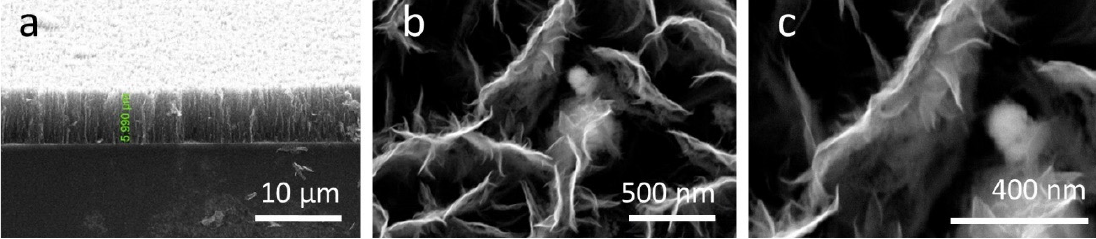
Figure 3. SEM images of CNW on silicon substrate: ( a ) cross-section of the CNW film showing a ~6 μ m height and less than 10 nm edges width; ( b ) top-view of CNW’s wall surface details showing the hydrophobicity-enhancing patterning and the distances between individual walls and ( c ) top view of CNW’s individual wall length and structure.